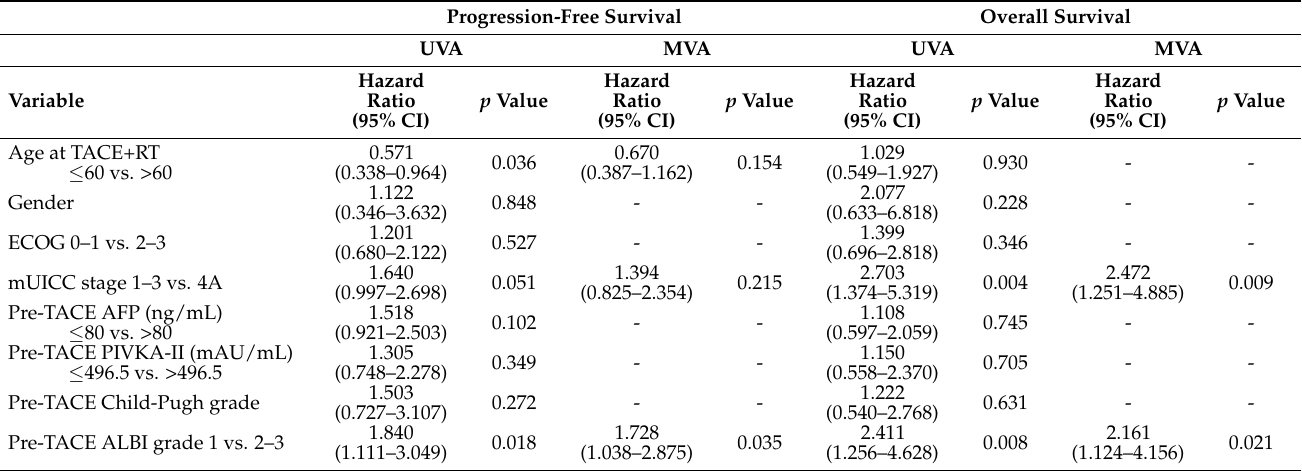
Table 3. Univariate and multivariate Cox proportional hazards associations between clinical factors and survival